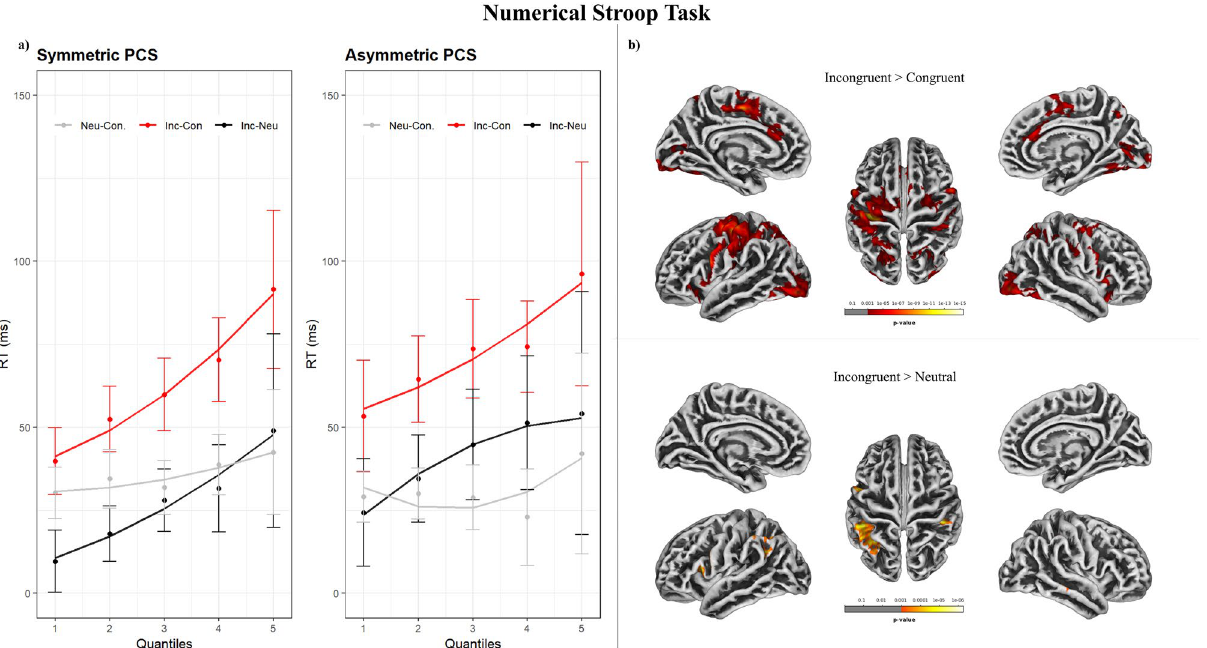
Figure 2. ( a ) Delta plots of the effects detected in the Numerical Stroop task, as a function of quantiles. ( b ) Brain activity during the Numerical Stroop task. Inc Incongruent, Con Congruent, Neu